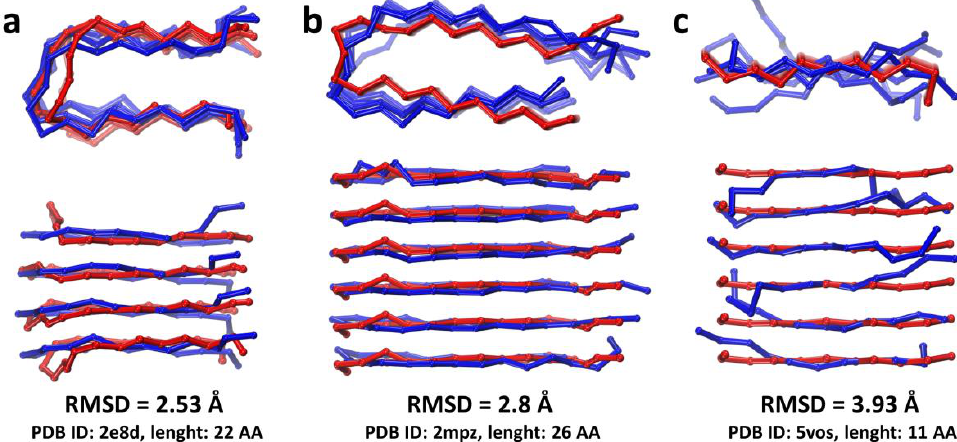
Figure 2. Predicted models of the three fibril structures. The model with the lowest RMSD value obtained from the set of 100 top-scored models is shown in C-alpha trace representation (color blue) and superimposed onto the reference experimental structure (color red) for each fibril: ( a ) 2e8d, ( b ) 2mpz and ( c ) 5vos. Fibril structures are shown from two different perspectives: along the long axis of the fibril (upper panel), and the side view (lower panel). At the bottom of each panel, the following information is included: RMSD value calculated for the predicted fibril, PDB ID of the reference structure, and the number of amino acid residues in the single peptide chain.